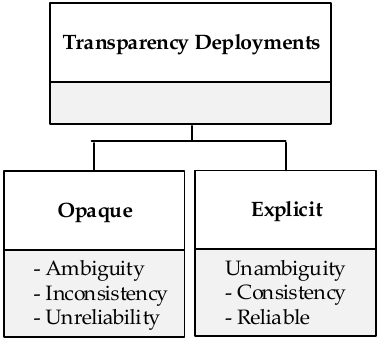
Figure 2. Cloud security transparency deployment practices.